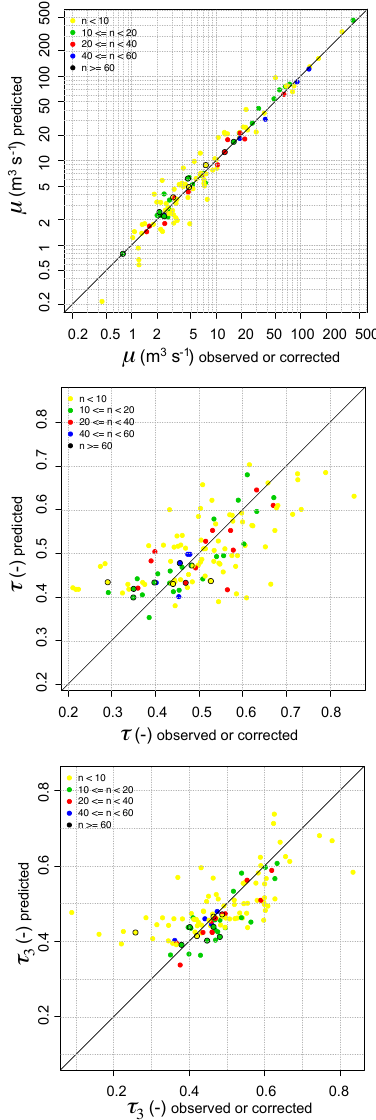
Figure 3. Natural values of the L -moments (observed or cor- rected) compared with regional predictions. Colors represent record lengths; circled points are the corrected values.